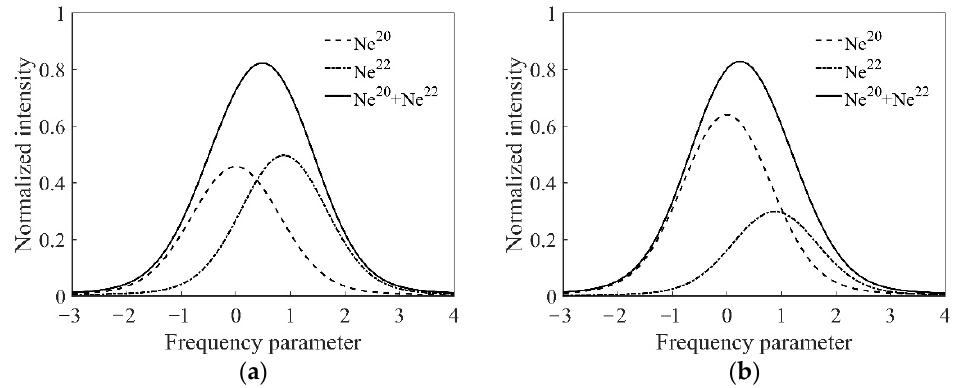
Figure 3. The normalized results of the intensity tuning curve in the ring laser gyro. ( a ) Ne 20 :Ne 22 = 1:1, inflation pressure 400 Pa; ( b ) Ne 20 :Ne 22 = 7:3, inflation pressure 400 Pa.